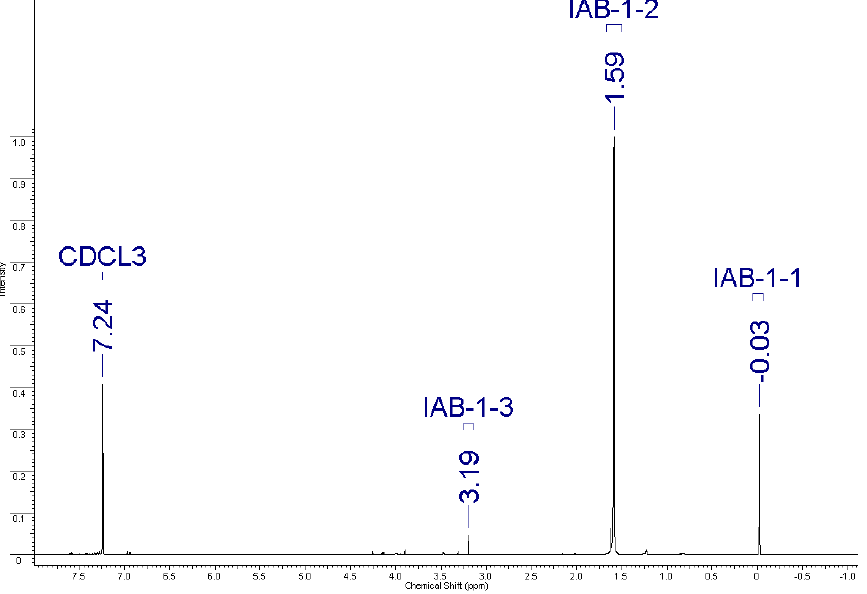
Figure 10. 1 H NMR spectra of SMCs without biocide.